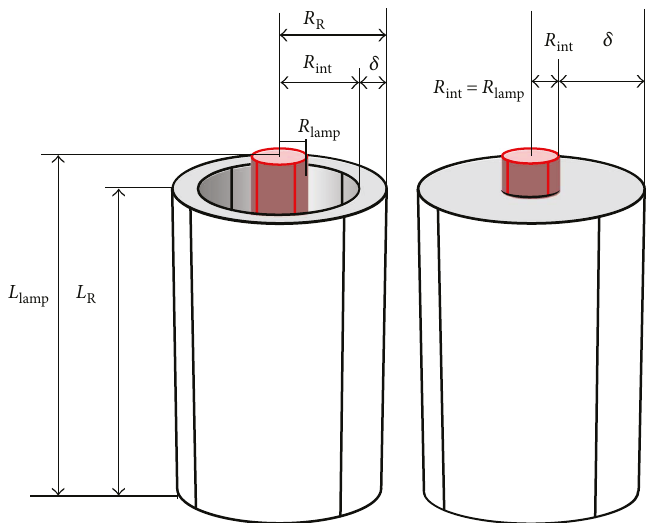
Figure 1: Schematic representation of the geometry of the assessed annular photocatalytic reactor.